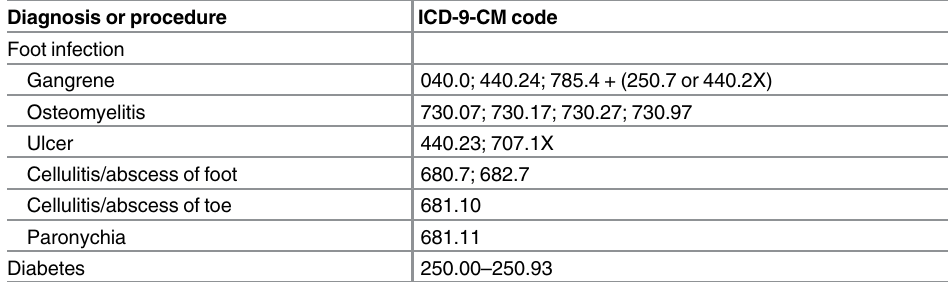
Table 1. ICD-9-CM codes for DFI, health outcomes, and